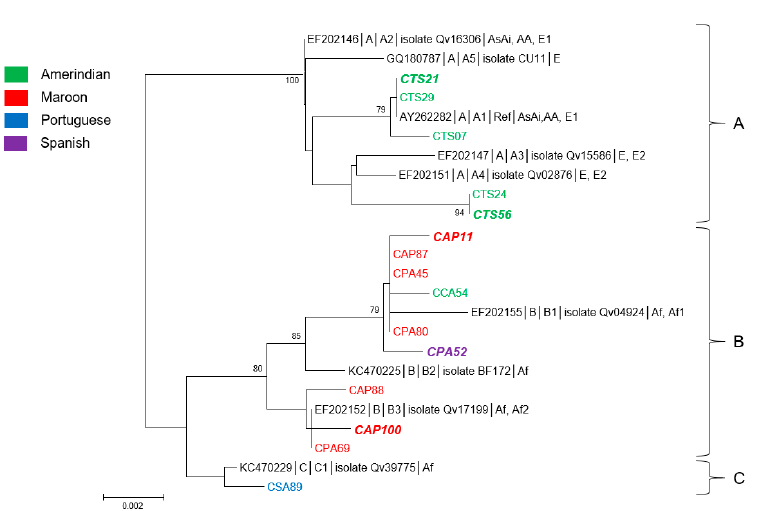
Figure 2. Phylogenetic tree of HPV18 variants from French Guiana. Maximum likelihood phylogenetic tree of HPV18 variants based on 789 bp of E6 and E7 concatenated sequences. Three clusters were identified as lineages A, B, and C. Only bootstrap values above 70% are represented in the branches. The tree is drawn to scale with branch lengths measured in the number of substitutions per site. Newly generated sequences, here identified by their IDs, are color-coded according to the mother tongue of the women from whom they were obtained. Oversized sequences in bold and in italics are those obtained from women with an abnormal cytology (either ASCUS, ASC-H, LSIL, HSIL, or glandular anomalies).